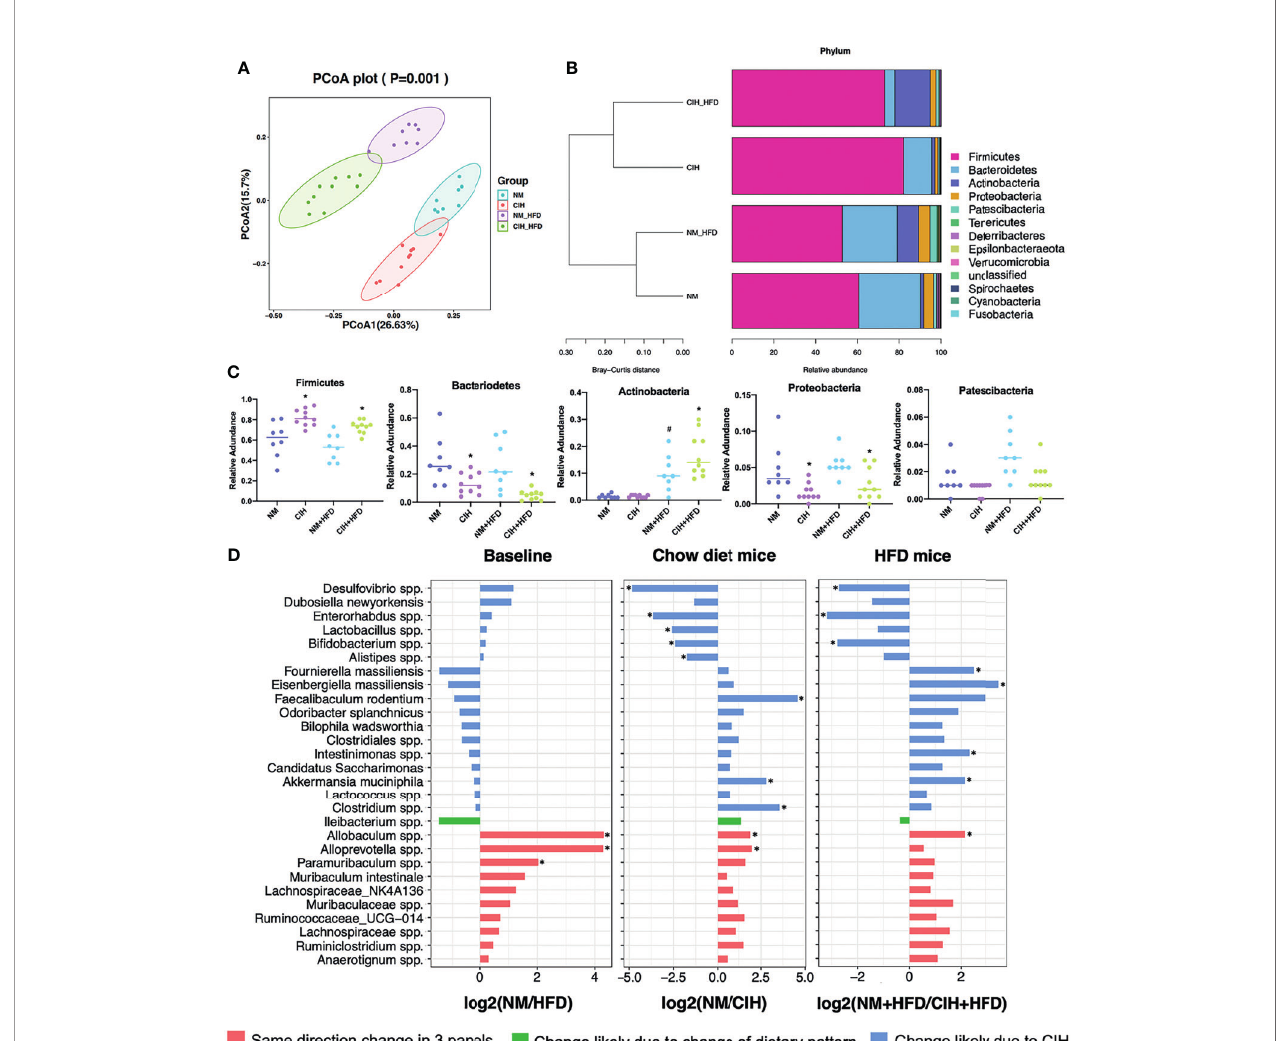
FIGURE 4 | Effects of CIH on fecal microbiota. (A) PCoA plot generated by using microbiota OTU metrics based on the Bray ‐ Curtis similarity for the NM, CIH, NM+HFD, CIH+HFD groups (n = 8-10/group). (B) The hierarchical cluster based on the Bray ‐ Curtis similarity of the samples from the NM, CIH, NM+HFD, CIH+HFD groups. The bar plot shows the abundance of each phylum in each sample. (C) The 5 most abundant phyla in the NM, CIH, NM+HFD, CIH+HFD groups. Data are expressed as mean ± SEM. Group differences were assessed by using the Mann ‐ Whitney U test. *P < 0.05 when comparing NM vs CIH, or NM+HFD vs CIH+HFD, # P < 0.05 when comparing NM vs NM+HFD. (D) Fold changes of the annotated microbes at the genus level. The data of log 2 FC are expressed as mean. Group differences were assessed by using the Mann ‐ Whitney U test. *P <